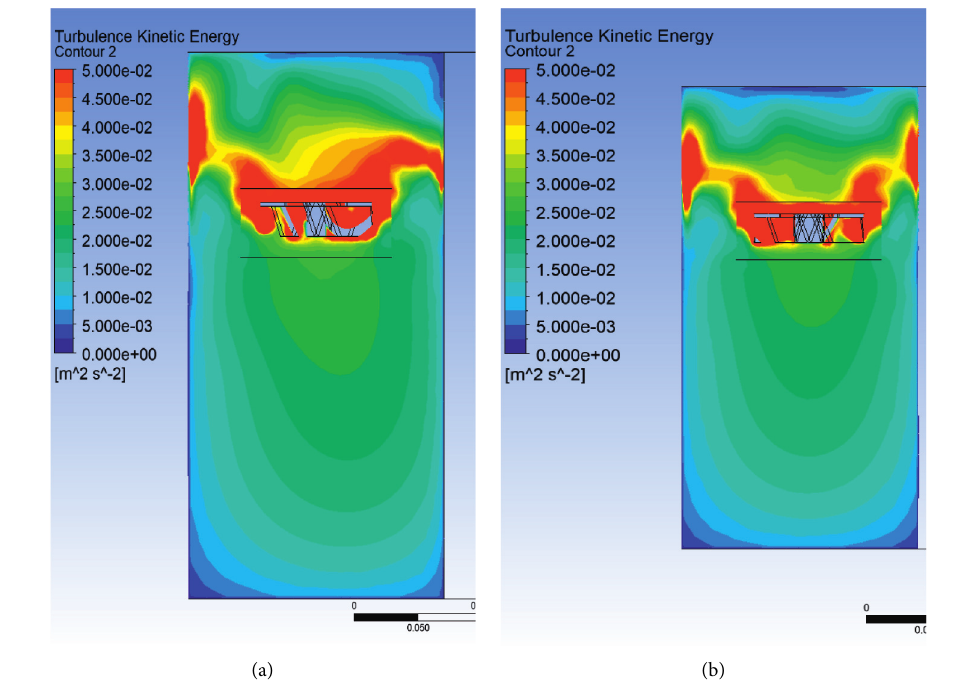
Figure 5: Turbulent kinetic energy cloud